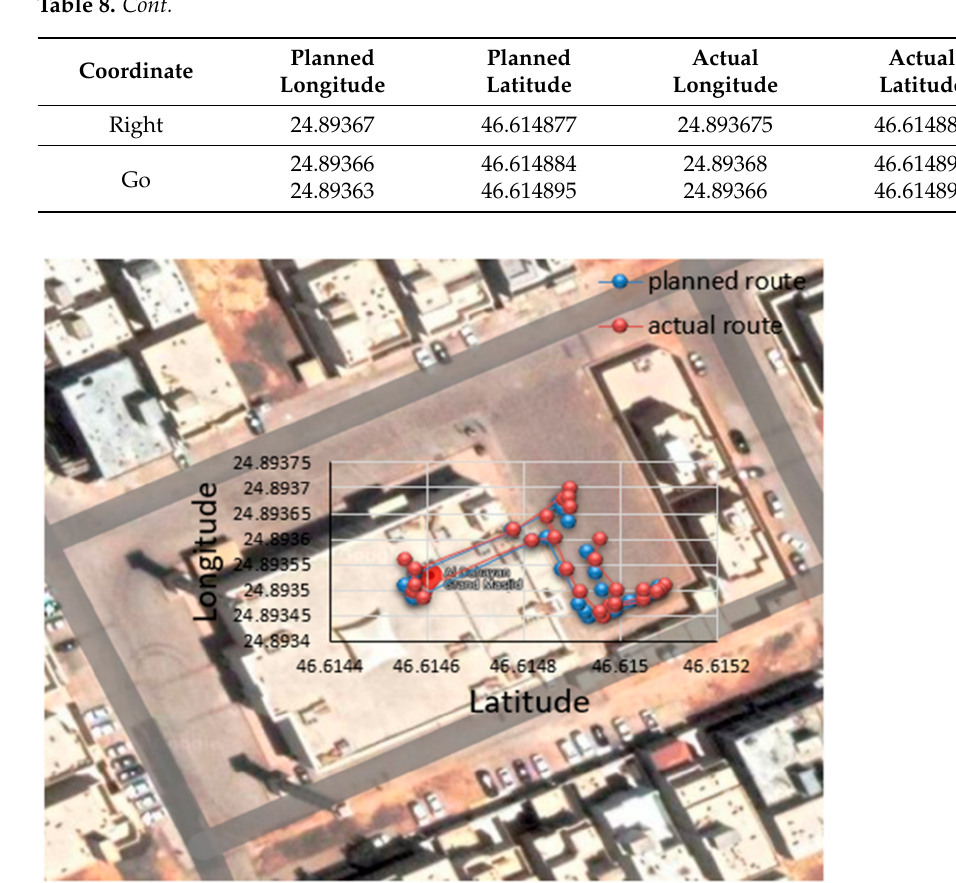
Figure 10. Navigation planned route versus actual